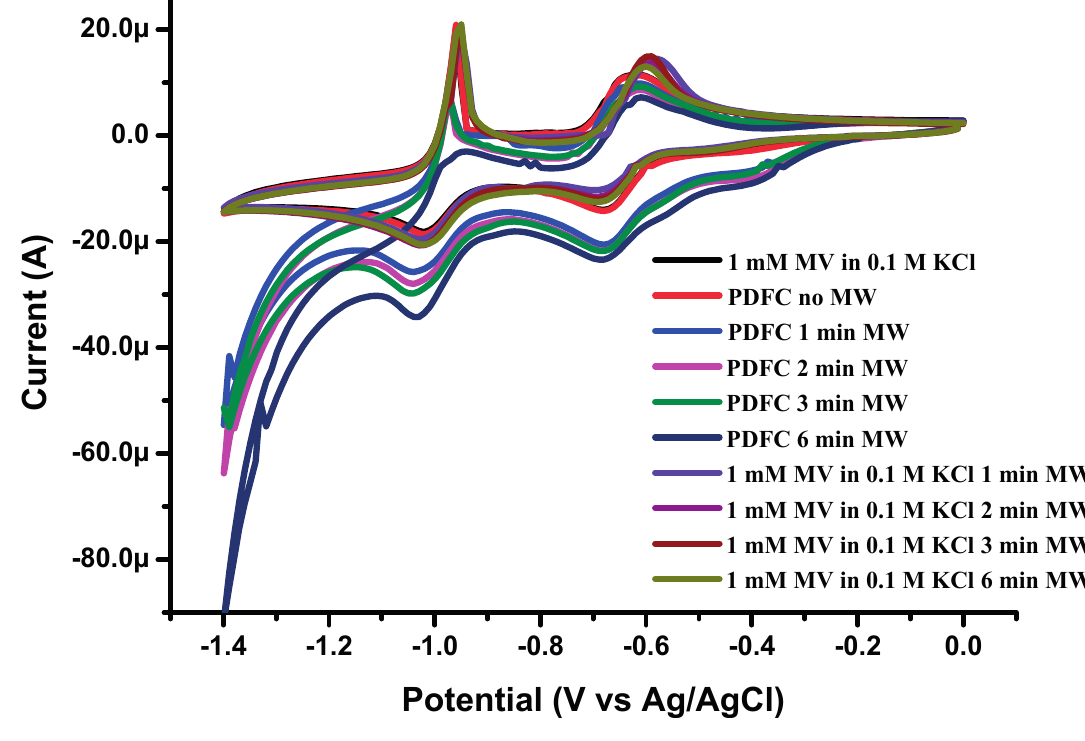
Figure 3. Cyclic voltammetry of 1 mM methyl viologen (MV) in 0.1 M